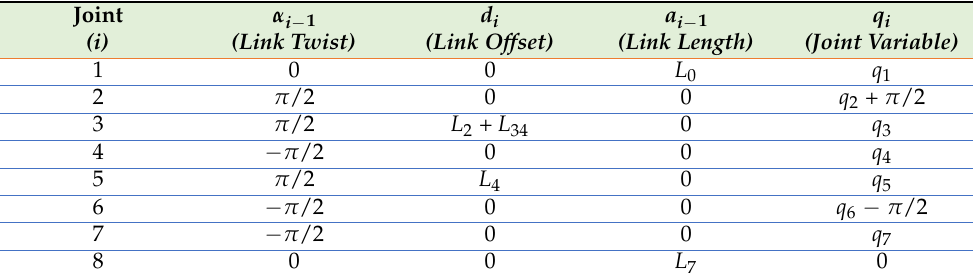
Table 4. Modified Denavit–Hartenberg parameters for the proposed exoskeleton robot.